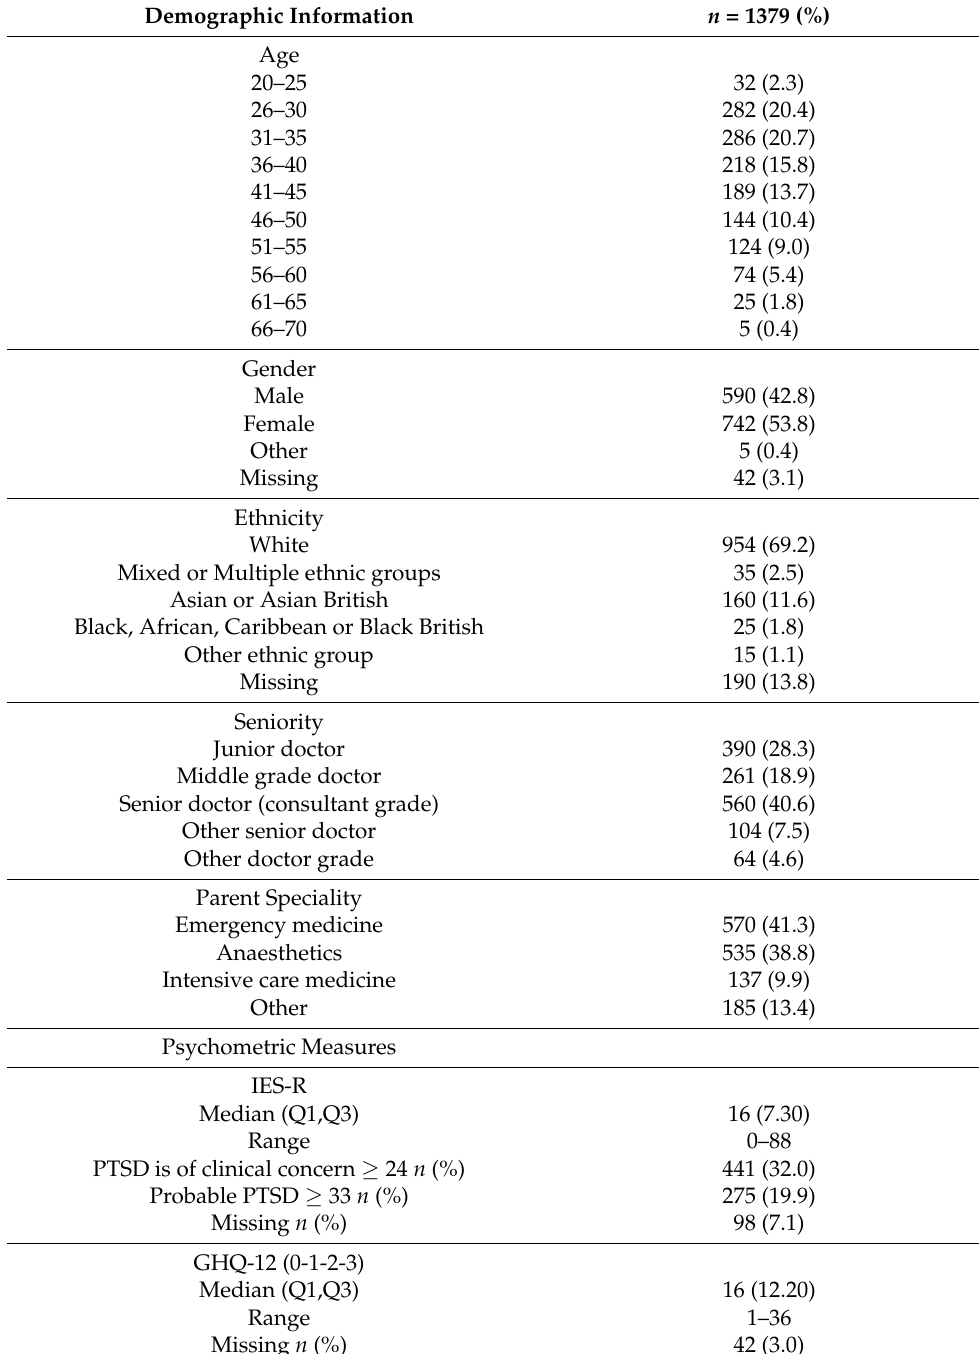
Table 1. Demographic and psychometric